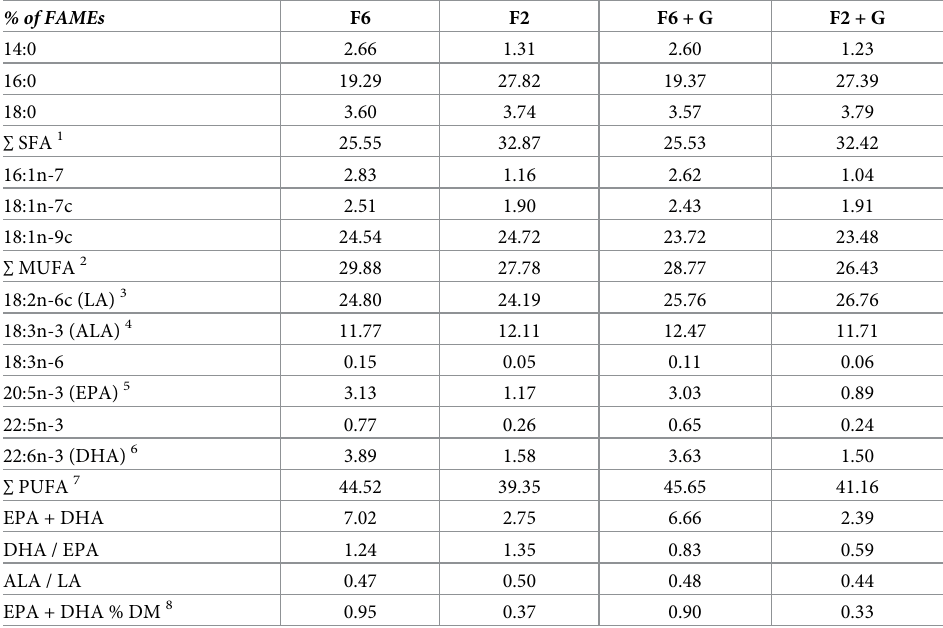
Table 2. Fatty acid composition (in % of total fatty acid methyl esters (FAMEs) and % of dry matter of diet (% DM)) of the experimental diets. F6 and F2 are the control diets containing 6% and 2% DM fish oil, respectively. +G indicates the supplementation of the control diets with 0.15% DM genistein.